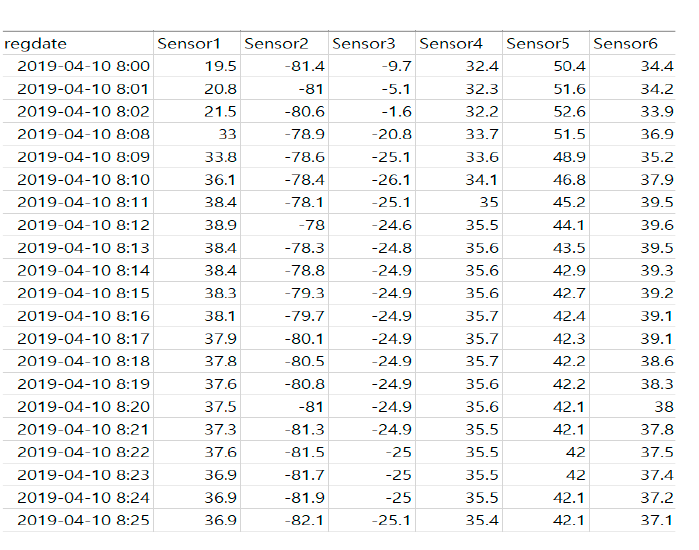
Figure 9. Temperature Sample data from six sensors attached to cryogenic freezer.